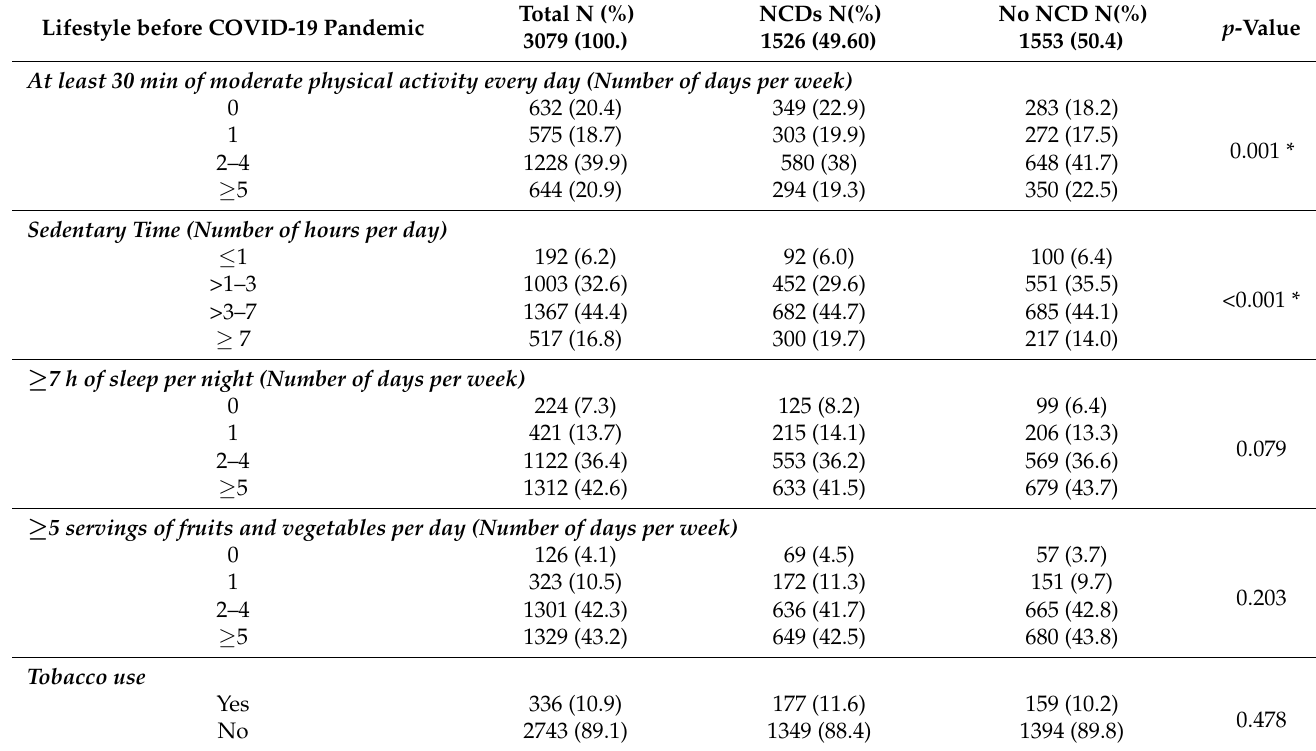
Table 2. Healthy lifestyle behaviors before the COVID-19 pandemic in people with and with- out